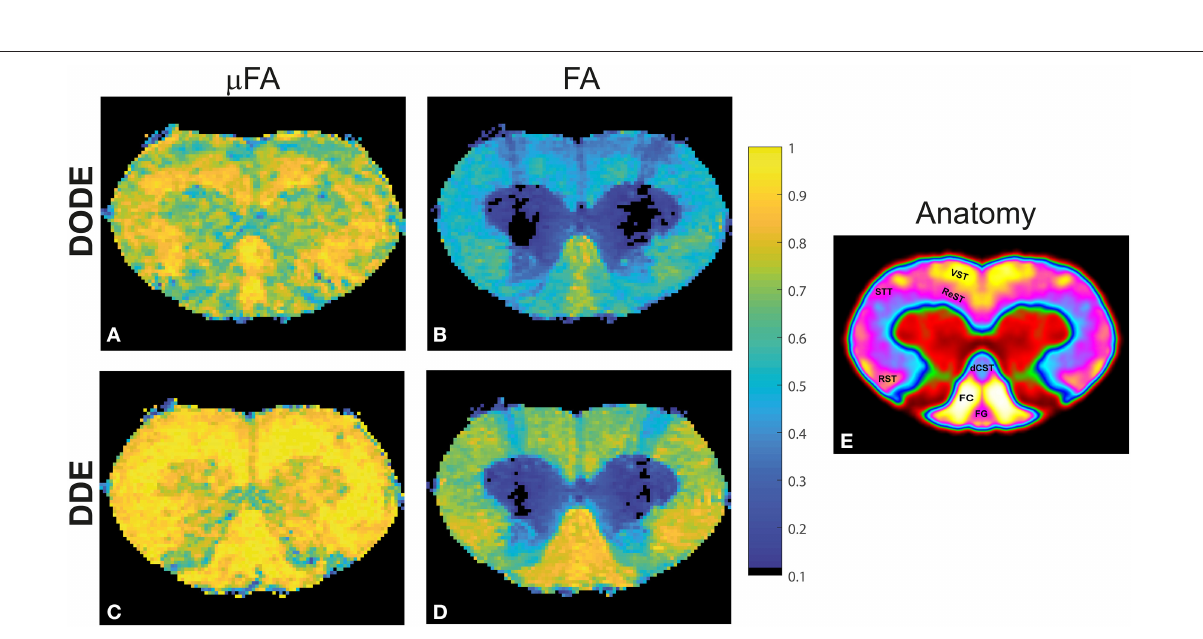
Frontiers in Physics |